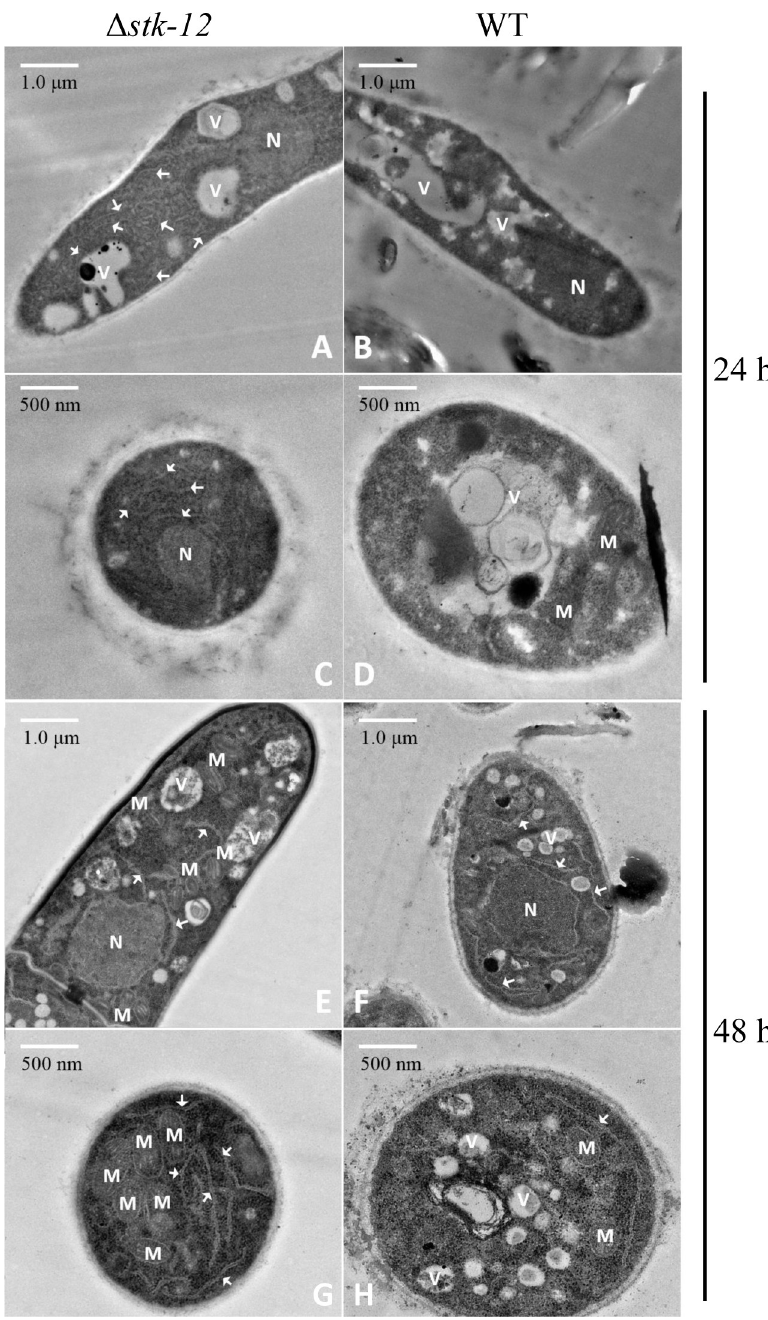
Fig 9. Transmission electron micrographs of N . crassa wild-type (WT) strain and stk-12 deletion strain. Δ stk-12 mutant (A, C, E and G) and N . crassa WT strain (B, D, F and H) were grown in minimal medium with 2% (w/v) Avicel as sole carbon source for 24 h (A-D) or 48 h (E-H). Mycelia were collected and prepared for transmission electron microscopy. White arrows indicate endoplasmic reticulum. M, mitochondrion; N, nucleus; V, vacuole. double mutant by crossing. As predicted, protein production and endoglucanase activity of the Δ stk-10 Δ stk-12 strain were restored to WT levels after 5 days of growth on Avicel (Fig 10). Overexpression of STK-12 led to defects in cellulase expression (Fig 5A). Taken together, these